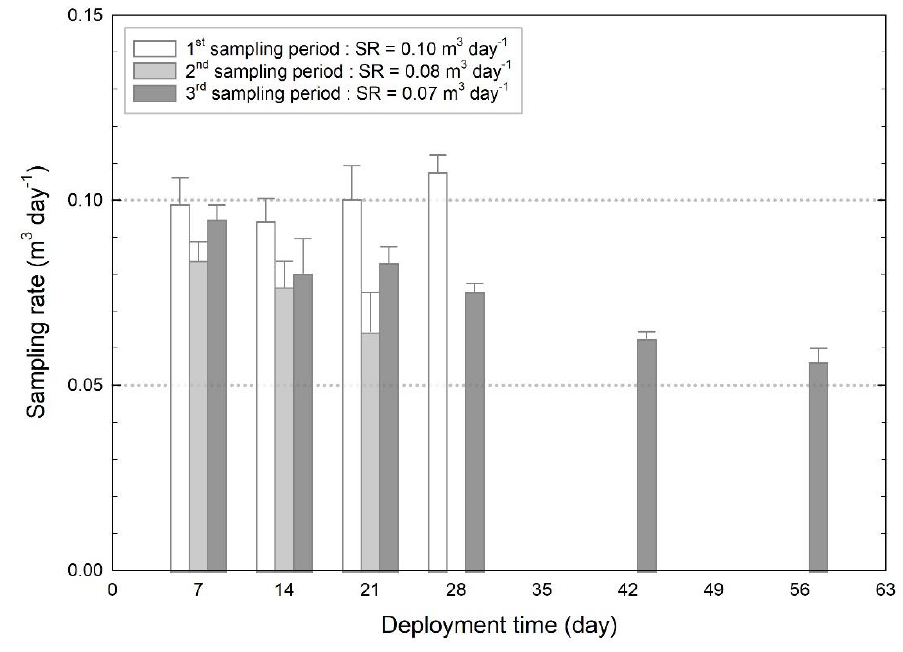
Figure 6. Experimental SR obtained from intensive measurement study.